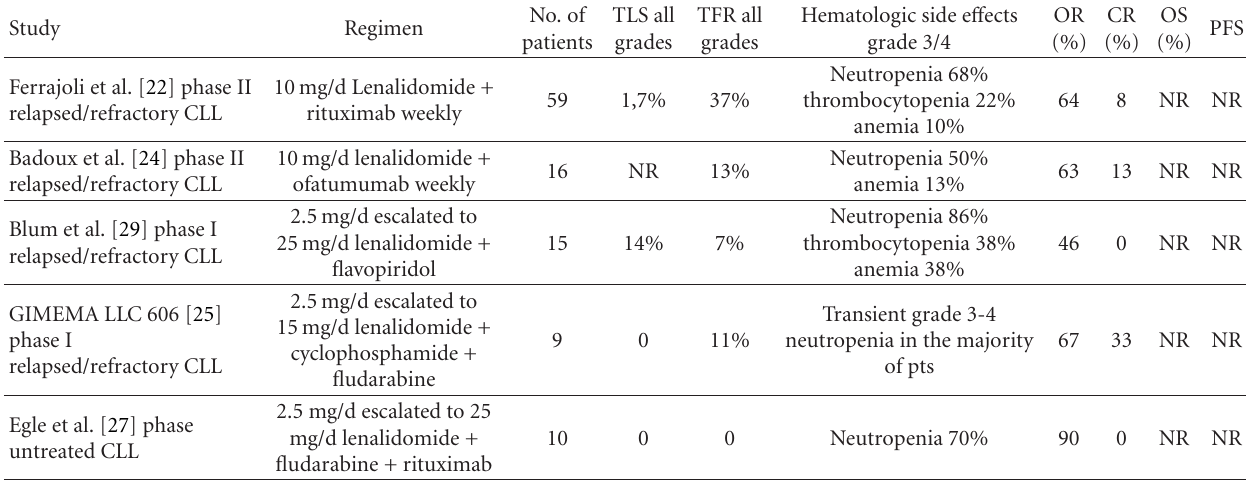
Table 2: Selected clinical trials using lenalidomide in combination for treatment CLL. NR: not reported.